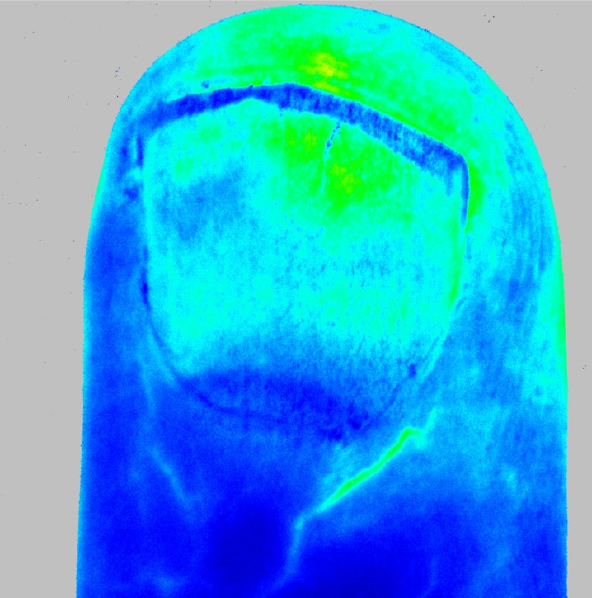
Figure 2. Laser speckle contrast analysis images of the distal–dorsal aspect of a finger in a patient with a “Late” scleroderma pattern of microangiopathy. Blue = low blood perfusion, yellow = intermediate blood perfusion, and red = high blood perfusion.